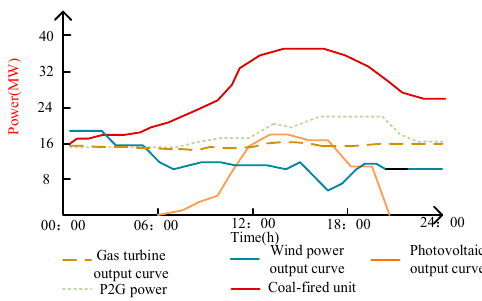
Figure 4. Operation plan of each unit under Scenario 1.